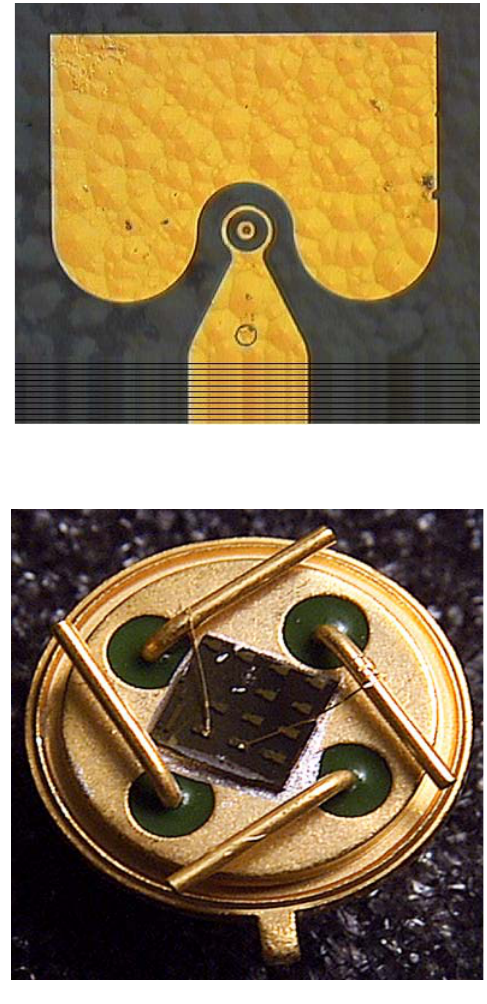
Figure 7. Photographs of two-terminal GaN Schottky diode for gas sensing applications (top) and packaged device